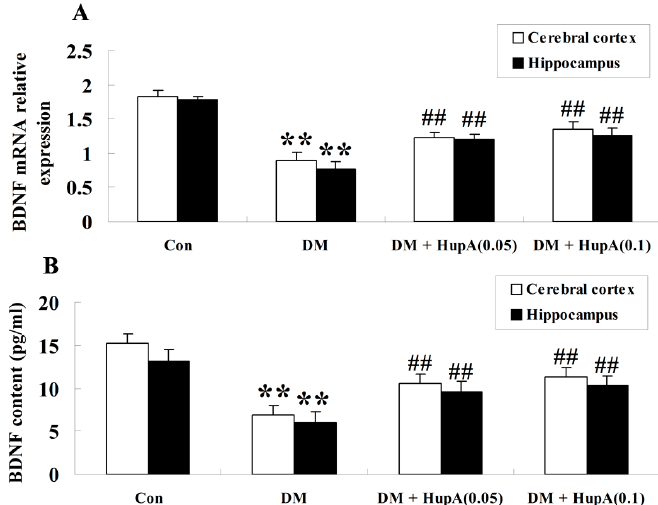
Figure 5. Effects of HupA on the mRNA ( A ) and protein levels ( B ) of BDNF in cerebral cortex and hippocampus of control and diabetic rats ( n = 8, mean ± S.D.). ** p < 0.01 compared with Con group; ## p < 0.01 compared with DM group. Con, control; DM, diabetes; DM + HupA (0.05), huperzine A (0.05 mg/kg)-treated; DM + HupA (0.1), huperzine A (0.1 mg/kg)-treated